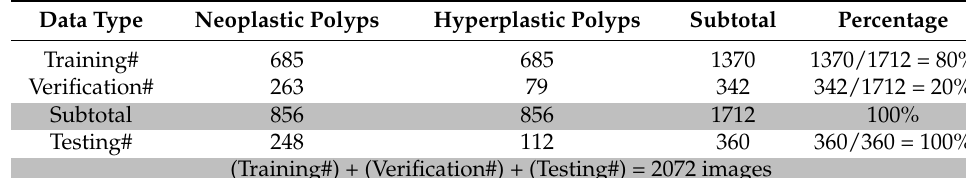
Table 15. Polyp classification dataset.